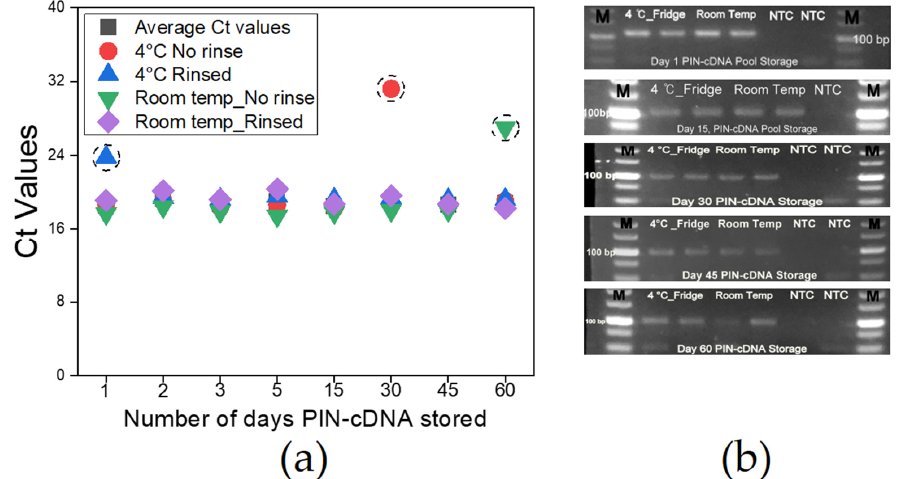
Figure 7. PIN ‐ cDNA pools storage conditions and duration ( n = 36); ( a ) A curve showing Ct values for different PIN ‐ cDNA pools stored at four different conditions; ( b ) Agarose gel electrophoresis showing expected DNA band sizes after storage for specific time intervals.